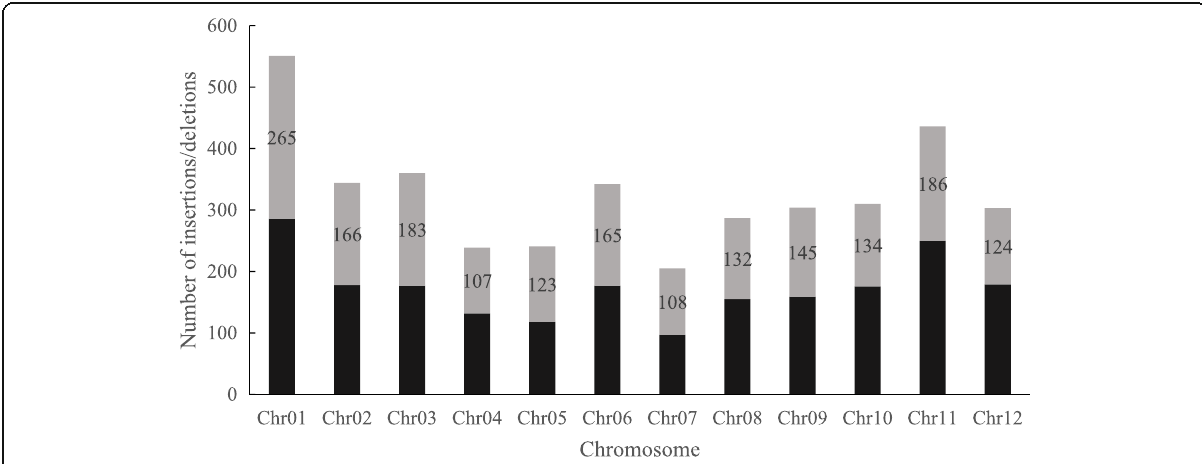
Fig. 1 The total number of 30 – 55 bp insertions/deletions and the number of potential agarose-resolvable LInDel markers. The total bar represents the total number of LInDels on each chromosome; the number in the gray bar represents the number of unique agarose-resolvable LInDels